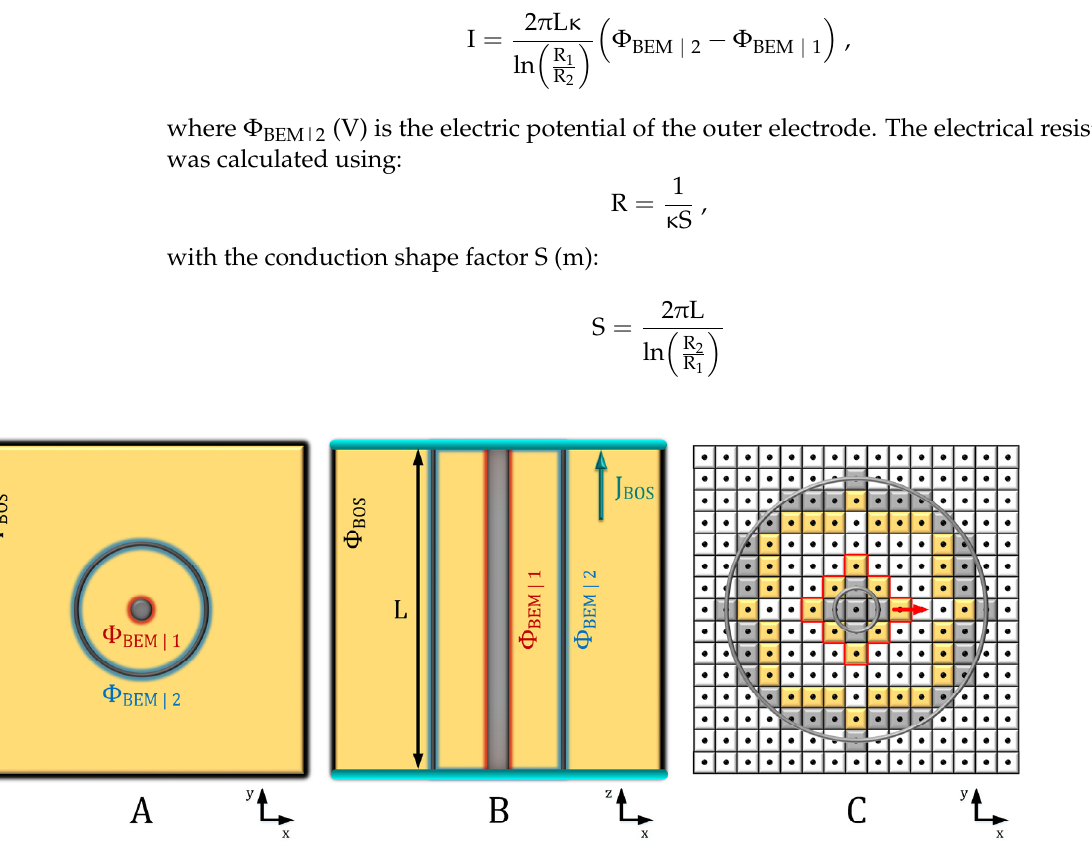
Figure 3. ( A ) The transverse plane of a coaxial cable model. The boundaries at the outer surface of the domain model (BOS) were assumed to be Φ BOS = 0 V. Please note that the modeling domain has an equilateral dimension in the x,y-plane. ( B ) The coronal plane of the model with the electrode of length L interposed between two isolation layers (color aqua blue), through which J BOS = 0 A·m − 2 . ( C ) Discretization of the inner and outer electrodes of the coaxial cables (represented by the circular lines). Electrode voxels are grey and their corresponding estimation voxels are represented by the orange voxels. The red contour represents the surfaces of the voxels that were used to calculate the electrical resistance.